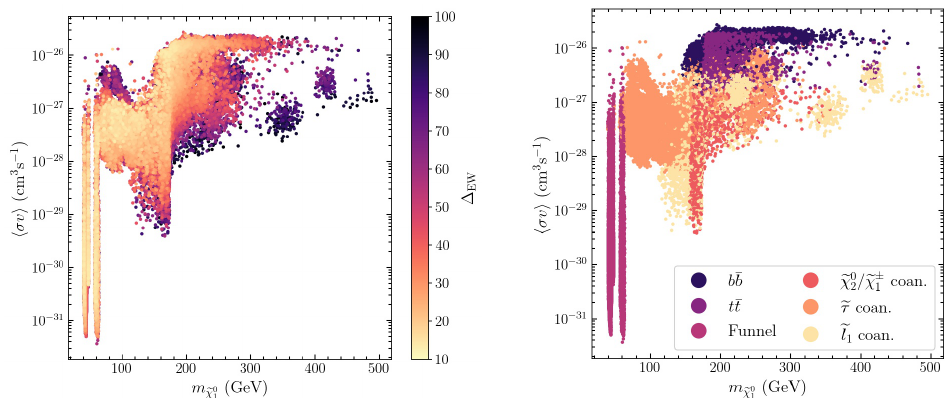
Figure 1: The mass of the DM particle ( m ) vs the velocity-weighted annihilation χ 0 (cid:101) 1 cross section ( 〈 σ v 〉 ). The value of ∆ is shown as a color code on the left, where the EW points are ordered such that spectra with lower values of ∆ lie on top of those with EW higher values of ∆ . On the right we show the dominant early-universe annihilation EW h 2 . In both plots, we only show points process that contributes to the value of Ω DM that satisfy all experimental constraints, and have 133 × 10 − 11 < ∆ a µ < 369 × 10 − 11 , allowing for a 2 σ